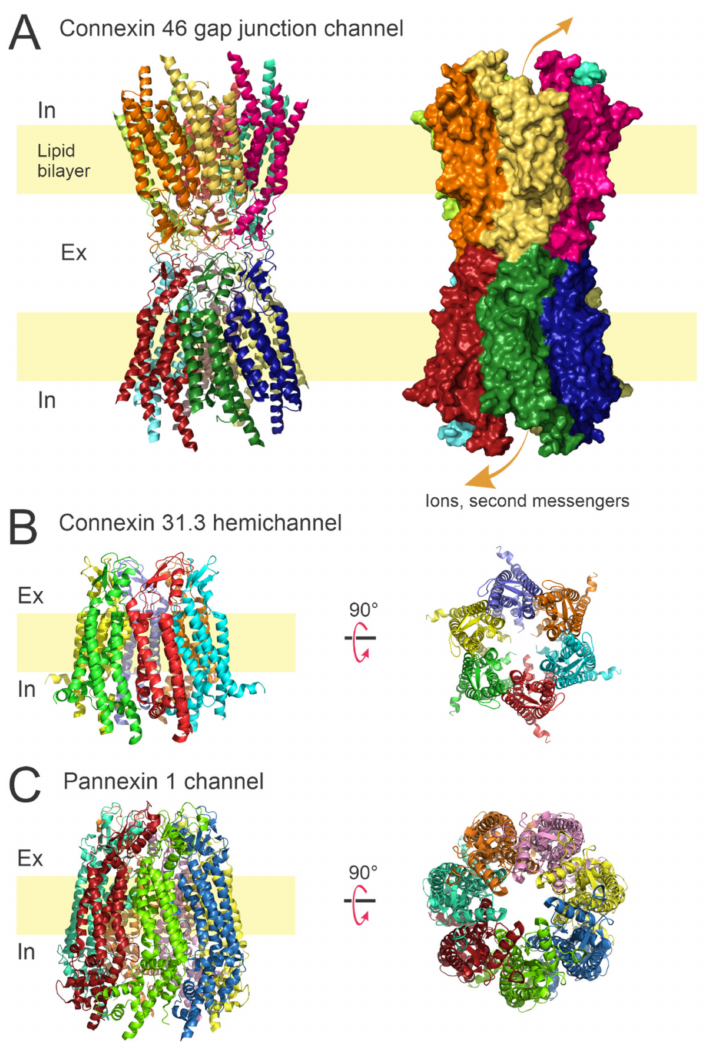
Figure 1. Overall architecture of gap junction channels, connexin hemichannels, and Panx-1 channels. ( A ) Ribbon and surface representations of the Cx46 GJ channel viewed from the lateral side. The dodecameric assembly allows the permeation of ions and small metabolites between adjacent cells. ( B ) Ribbon model for the Cx31.3 hemichannel viewed from lateral side ( left ) and from the extracel- lular side ( right ). Hemichannels assemble in hexamers and provide a conduction pathway for ions and small molecules between extracellular and intracellular compartments. ( C ) Ribbon represen- tations of the Panx-1 channel. Panx-1 channels assemble as heptamers and provide a pathway for paracrine/autocrine signaling. Protein data bank (PDB) codes: 7JKC (Cx46) [36], 6L3U (Cx31.3) [37], and 6WBF (Panx-1)